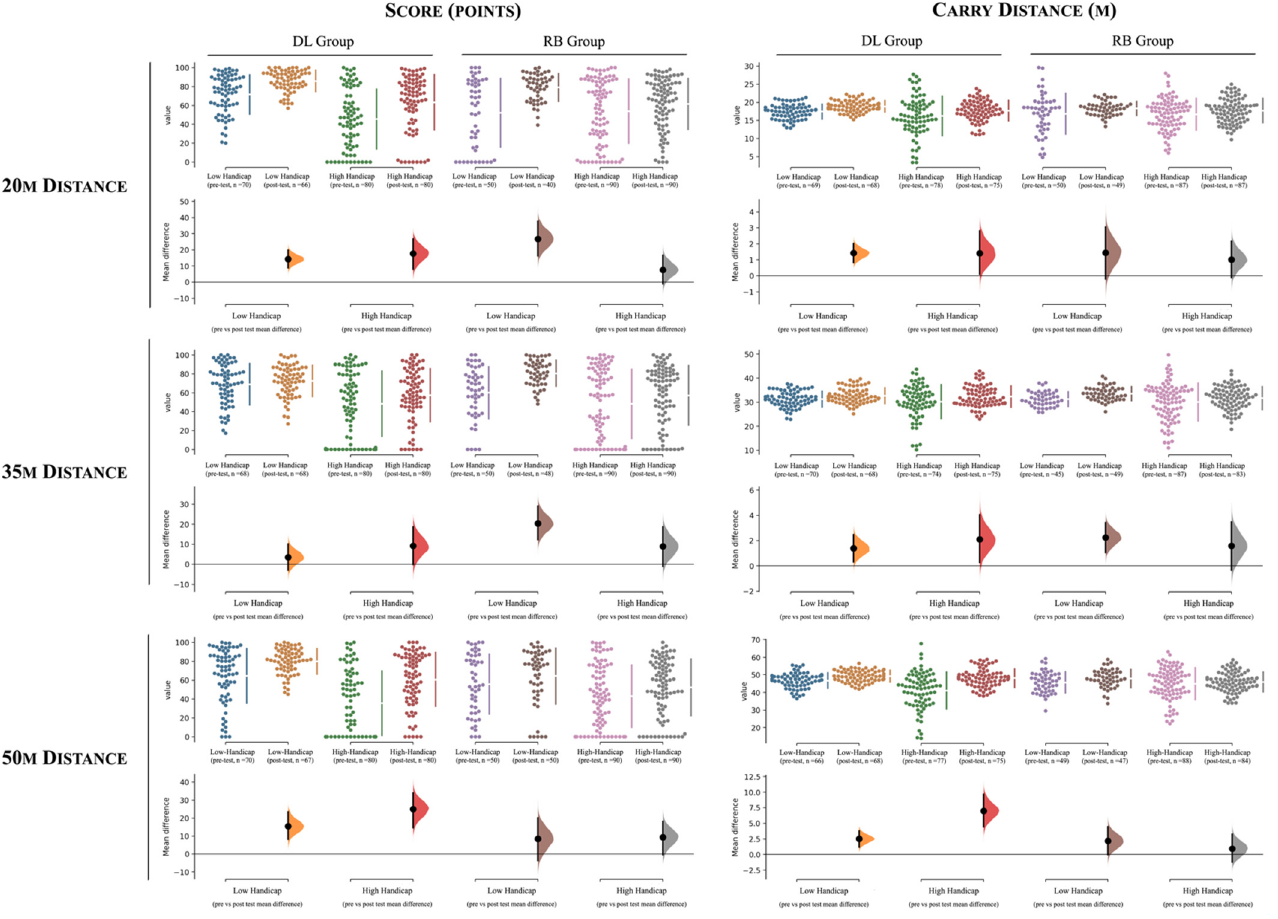
Figure 3. The mean difference for 4 comparisons according to: (i) the score and carry distance and to (ii) distances (20 m, 35 m, and 50 m) are shown in the above Cumming estimation plot. The raw data are plotted on the upper axes; each mean difference is plotted on the lower axes as a bootstrap sampling distribution. Mean differences are depicted as dots; 95% confidence intervals are indicated by the ends of the vertical error bars [45]. DL = differential learning; RB = repetitive-based. The training intervention for the 35 and 50 m distance showed similar trends between the groups. Accordingly, higher improvements in scores (35 m, F = 7.61, p = 0.007; 50 m, F = 13.81, p < 0.001, small effects) were found for the high handicap group (i.e., low level). In contrast, higher improvements for club speed (35 m, F = 4.56, p = 0.035; 50 m, F = 22.1, p < 0.001, moderate and small effects for the 35 and 50 m distance respectively) were identified for the low handicap group. In addition, an increase in the negative attack angle (35 m, F = 4.17, p = 0.045; 50 m, F= 3.96, p = 0.05, moderate and small effects for the 35 and 50 m distance respectively) and a decrease in dynamic loft (35 m, F = 11.3, p = 0.001; 50 m, F = 10.36, p = 0.002, moderate effects) for the low handicap group were found, while an increase in the positive face angle (35 m, F = 8.04, p = 0.005; 50 m, F = 5.71, p = 0.018, moderate effects) values in comparison to the high handicap group were found.